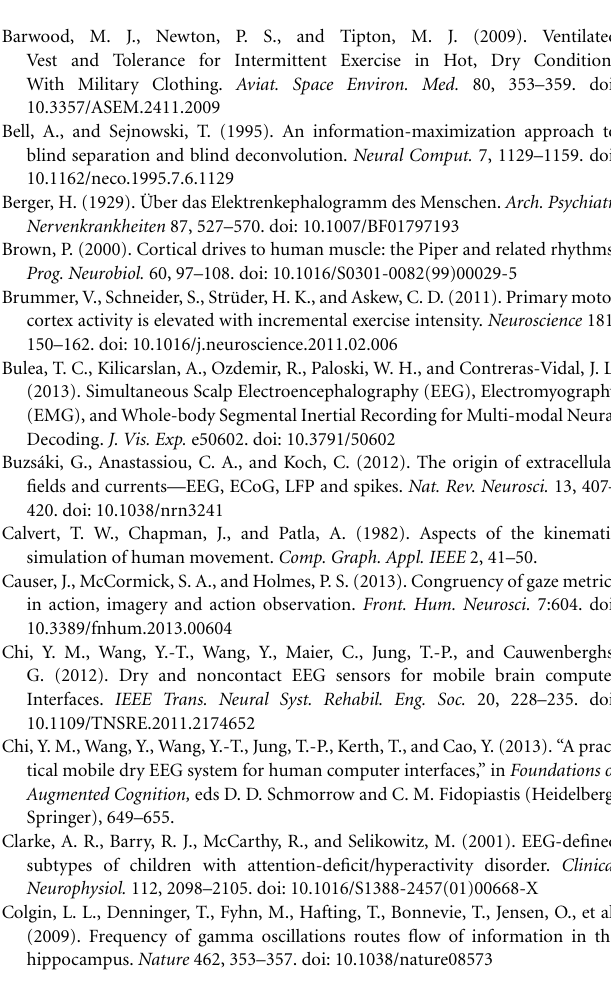
Component localized at the back of the head with high power content above 30Hz which is consistent with EMG activity (Goncharova et al., 2003). This component should be considered for rejection which can be realized with